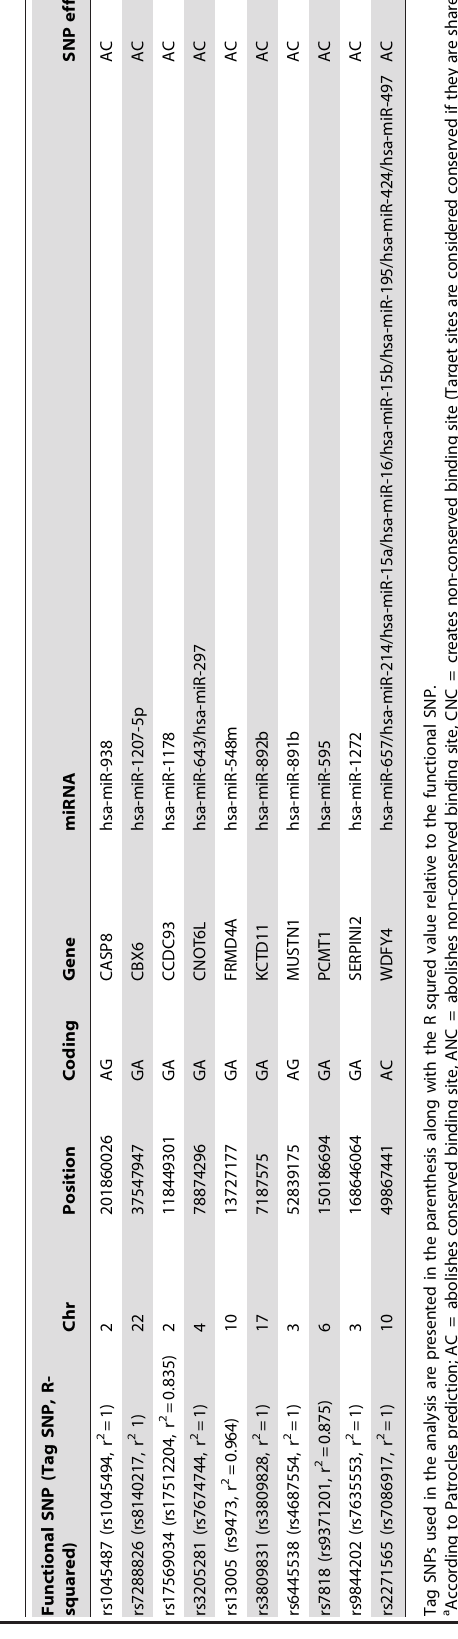
Table 2. The most significantly associated SNP, rs702681 (OR 1.06 [95%CI 1.04–1.08]; P 3.9 6 10 2 10 ), is located in the 3’UTR of MIER3, close to the known breast cancer susceptibility gene MAP3K1. The SNP rs702681 is located at the same 5q11.2 locus as the previously published risk SNP rs889312 [33] (correlation r 2 =0.3). When the two SNPs were analysed in the same logistic regression model, the association with rs889312, but not that with rs702681 remained nominally statistically significant, suggesting that rs702681 is unlikely to be the causal SNP at this locus. The five SNPs with the significant novel associations from the meta- analysis ( P # 5.07 6 10 2 3 and adjusted P # 3.55 6 10 2 2 after correc- tion for multiple testing) were rs1045494, (OR 0.92 [95%CI 0.88– 0.96]; P = 5.90 6 10 2 5 ), rs1052532, (OR 0.97 [95%CI 0.95–0.99];